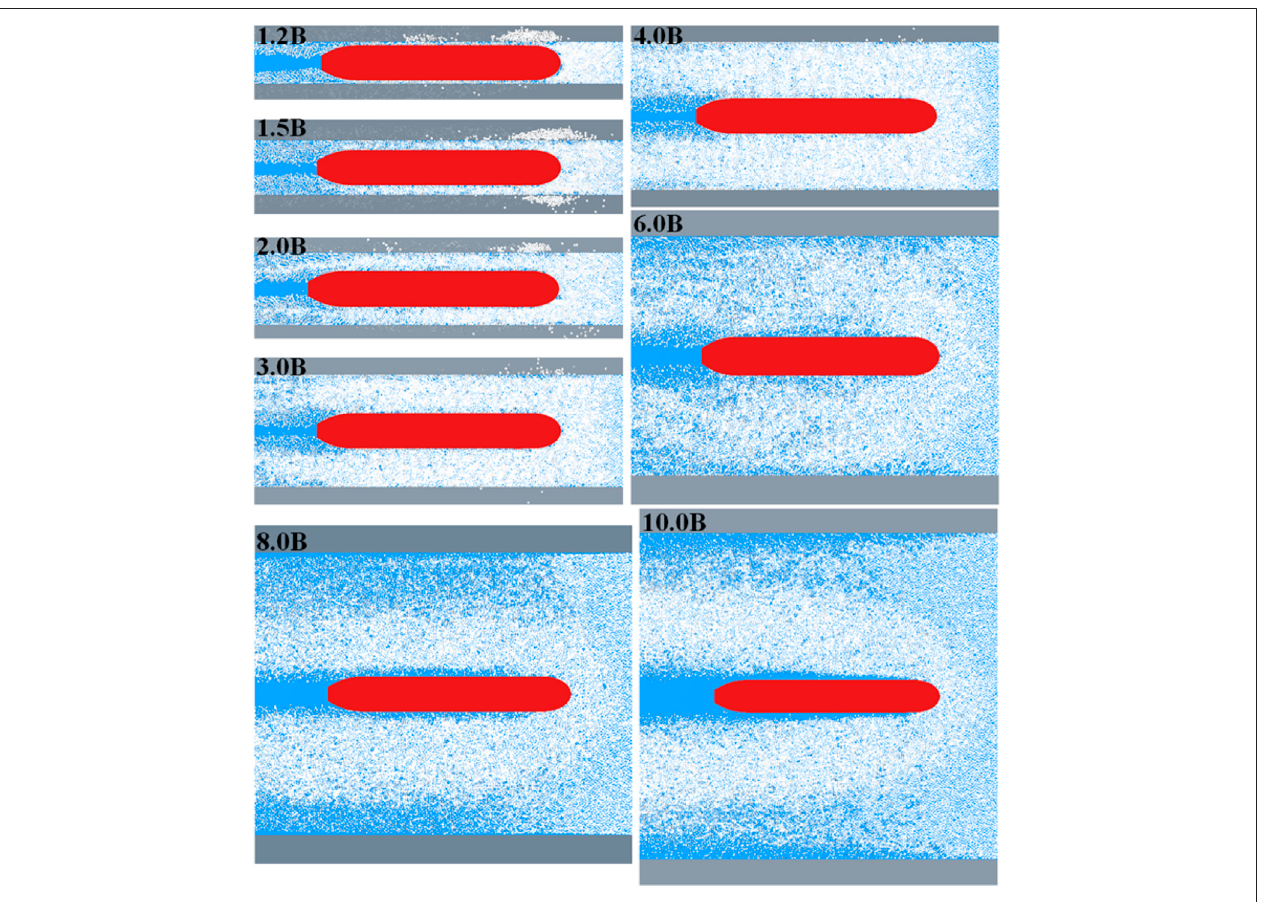
FIGURE 16 | Numerical simulations with different widths of brash ice